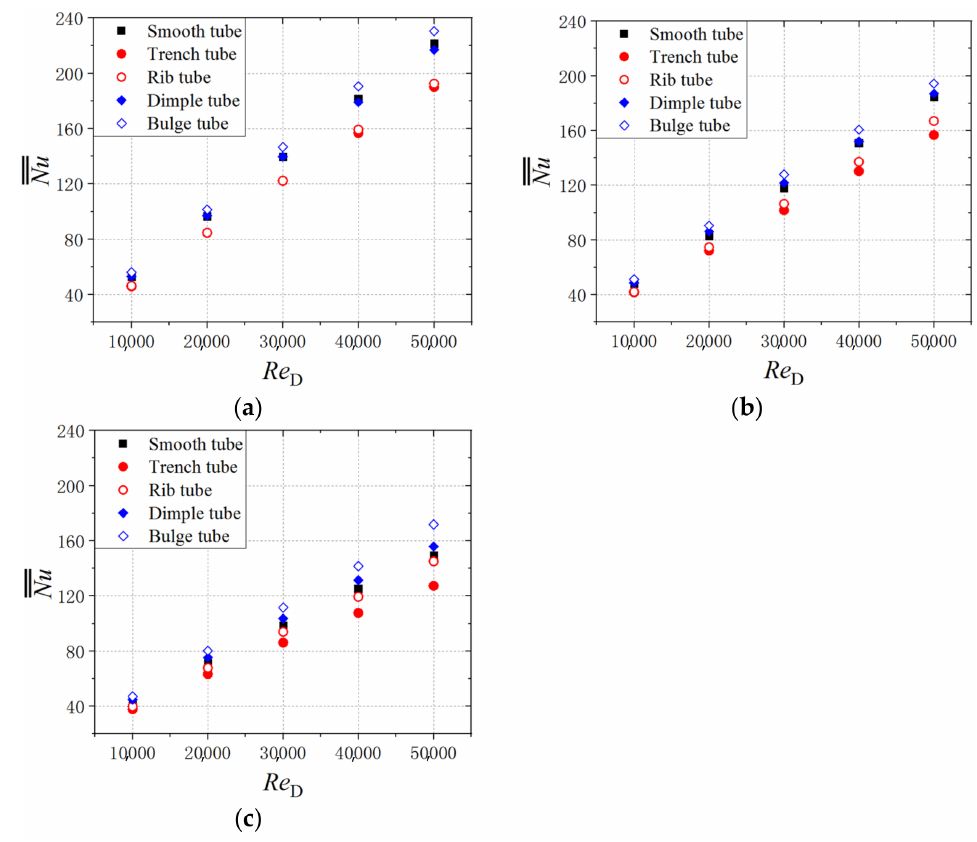
Figure 8. Comparisons of the area-averaged Nusselt number on the smooth tube and the structured tube at different Re D values: ( a ) three jets; ( b ) five jets; ( c ) nine